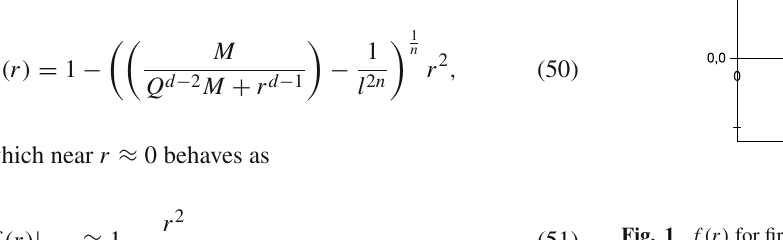
Fig. 1 f ( r ) for first family of solutions with toy values of Q = 1